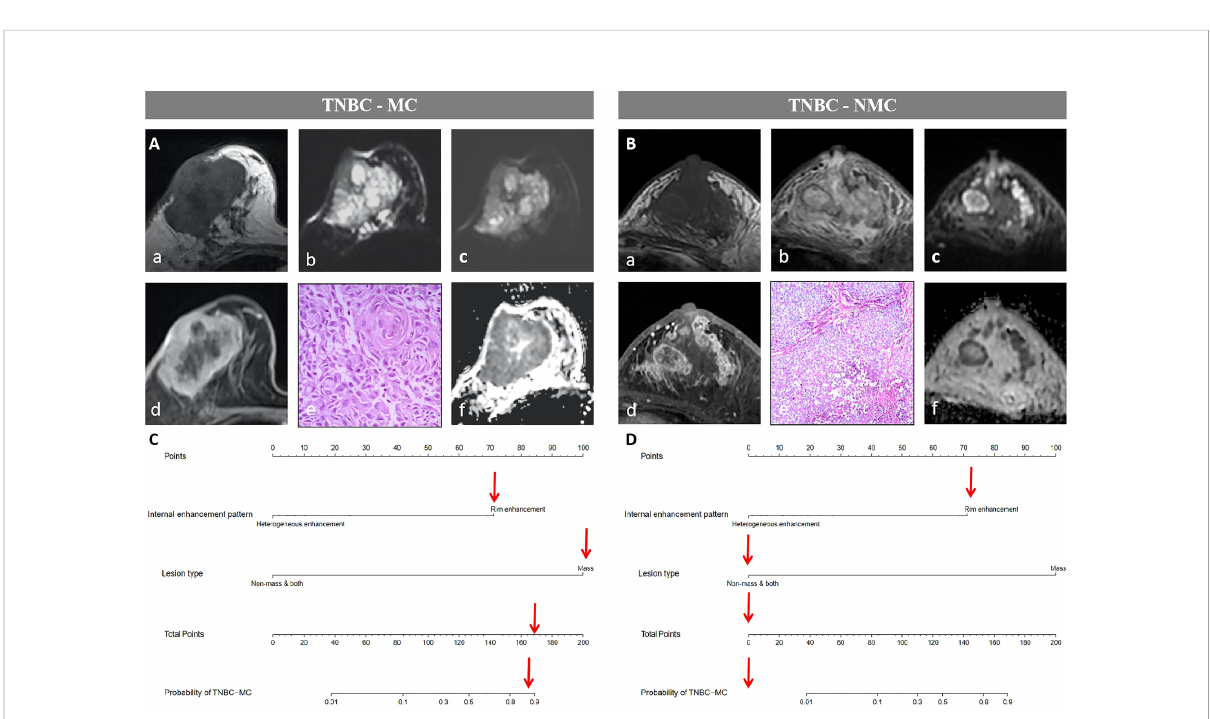
FIGURE 5 Examples of the nomogram in use. (A) Breast MRI examination of a 59-year-old TNBC-MC patient. A(a) The lesion showed iso- or hypo- intense signal on T1WI. (b)T2WI showed the lesion with hyperintense signal on T2WI. (c) Diffusion-weighted imaging (DWI) showed inhomogeneous iso- or hyper- intense signal. (d) The lesion showed mass type with circumscribed margin, and rim enhancement. (e) HE staining (×40), squamous cell carcinoma be observed under microscope. (f) Apparent diffusion coef fi cient (ADC) showed hypointense. (B) Breast MRI examination of a 61-year-old TNBC-NMC patient. B(a) The lesion showed hypo- intense signal on T1WI. (b)T2WI showed the lesion with iso- or hyper- intense signal on T2WI. (c) DWI showed signi fi cantly inhomogeneous iso- or hyper- intense signal. (d) The lesion showed both type (mixed type with mass and nonmass) with not clear margin, and heterogeneous enhancement. (e) HE staining (×10), non-invasive carcinoma be observed under microscope. (f) ADC showed signi fi cantly inhomogeneous hypointense. (C) The possibility of MC assessed by nomogram could be more than 80%. (D) The possibility of MC assessed by nomogram could be less than